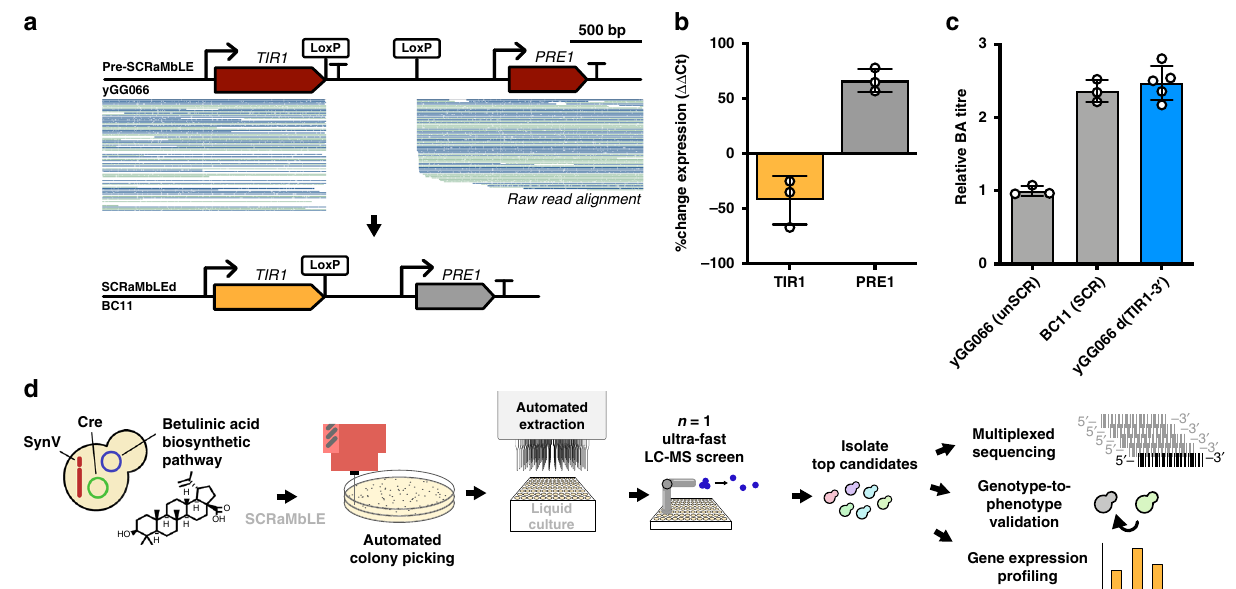
Fig. 3 Characterisation of BC11 indicates a genotype-to-phenotype relationship. a SCRaMbLE strain BC11 exhibited a single recombination event between adjacent LoxPsym sites. This was identi fi ed by aligning all raw reads to a pre-SCRaMbLE reference sequence (blue and green lines show individual reads, coloured by direction). The inferred SCRaMbLE event was a deletion of the TIR1 3 ′ UTR (con fi rmed by PCR, Supplementary Fig. 6). b Quantitative PCR was performed on the SCRaMbLE BC11 strain in biological and technical triplicates. The mean of three technical repeats for each biological repeat ( n = 3) was used to fi nd the biological replicate mean and standard deviation (shown here). c BA titre for yGG066 (negative control, n = 3 biologically independent samples) and BC11 (positive control, n = 3 biologically independent samples) is shown compared to yGG066 d( TIR1 -3 ′ ) (blue, n = 5 biologically independent samples). Mean and standard deviation shown. d The entire work fl ow developed in this study is shown. Following mass genome diversi fi cation strains are screened using ultra-fast LC-MS to identify the top candidates. These candidates are then subject to downstream characterisation to gain new insight (multiplexed sequencing, genotype-to-phenotype validation, and gene expression analysis). Source data are provided as a Source Data fi